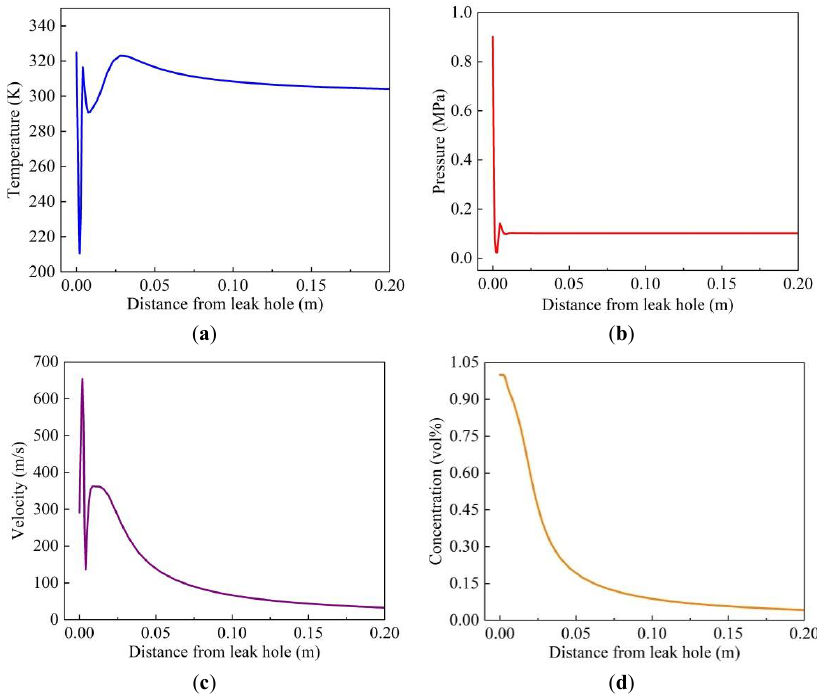
Figure 7. Flow field distribution on the jet axis in the local flow area below the leakage hole: ( a ) temperature curve; ( b ) pressure curve; ( c ) velocity curve; ( d ) concentration curve.